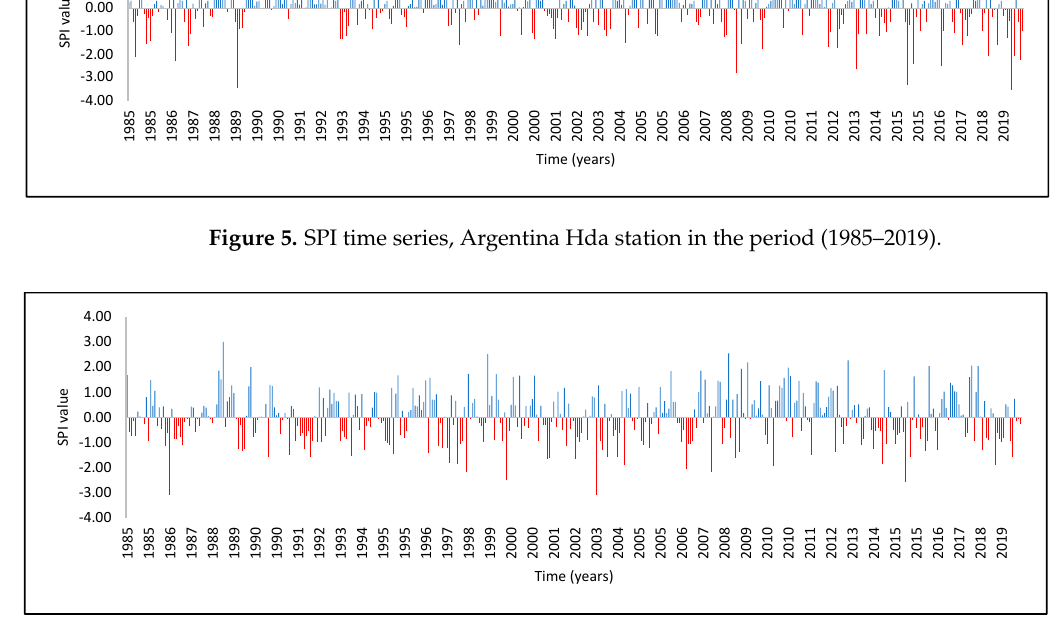
Figure 7. SPI time series, Rafael Bravo station in the period (1985–2019). Figure 8. SPI time series, Primate station in the period (1985–2019).